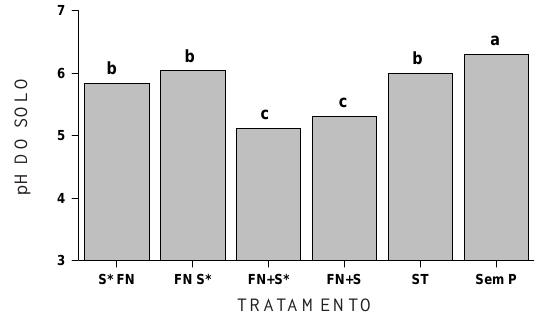
Figura 8. pH do solo nos tratamentos FN revestindo o enxofre inoculado com Acidithiobacillus (FN S*), FN revestido com S inoculado com Acidithiobacillus (S* FN), mistura FN com S inoculado com Acidithiobacillus (FN + S*), mistura FN com S sem Acidithiobacillus (FN + S), superfosfato triplo (ST) e sem adição de fósforo (sem P). Letras minúsculas comparam as médias dos diferentes tratamentos com fertilizantes. C.V. % =